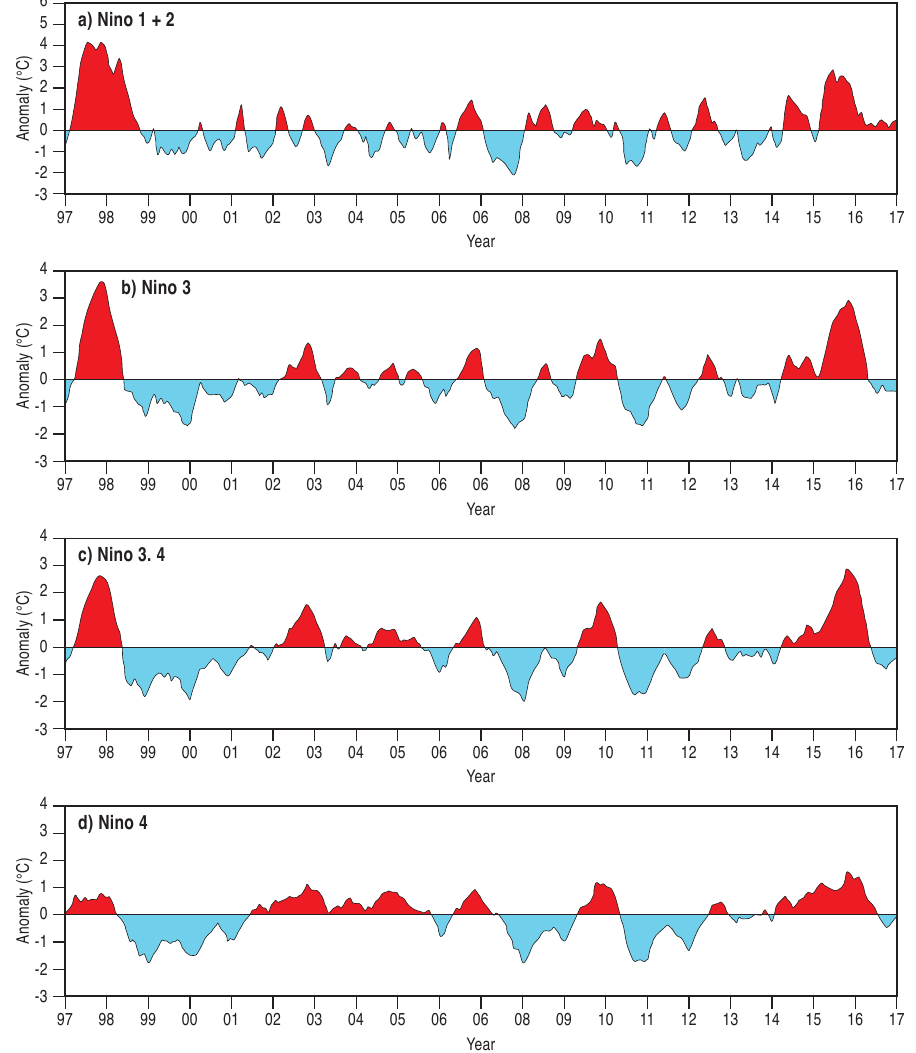
Figure 6. Time series of SST anomalies ( ◦ C) for NIÑO regions (see Table 2 and Figure 5) 1997–2016. The strong positive SST anomalies are especially apparent for the 1997–1998 and 2015–2016 El Niño events. Notice also how the SST anomalies generally decrease in magnitude to the west. Sourced and redrawn from the Climate Diagnostics Bulletin